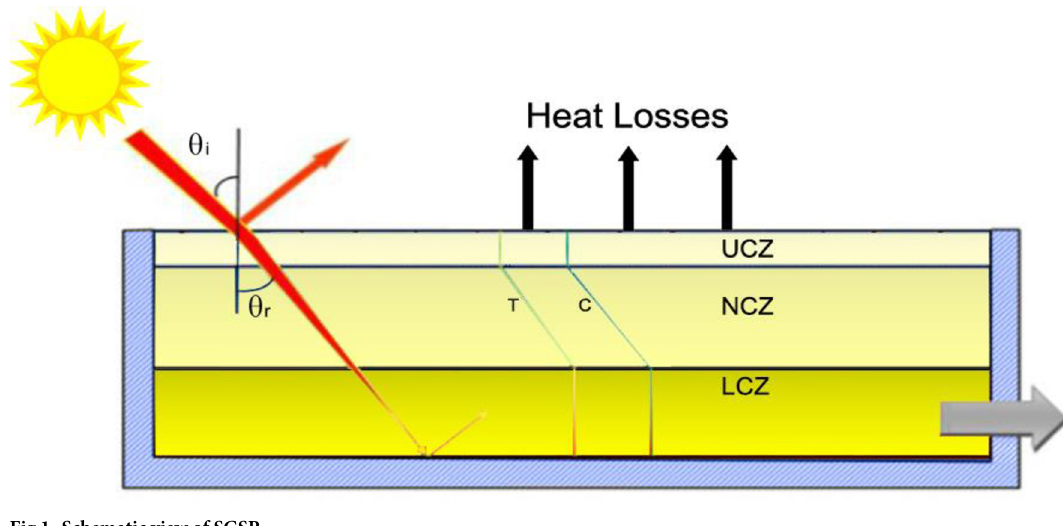
Fig 1. Schematic view of